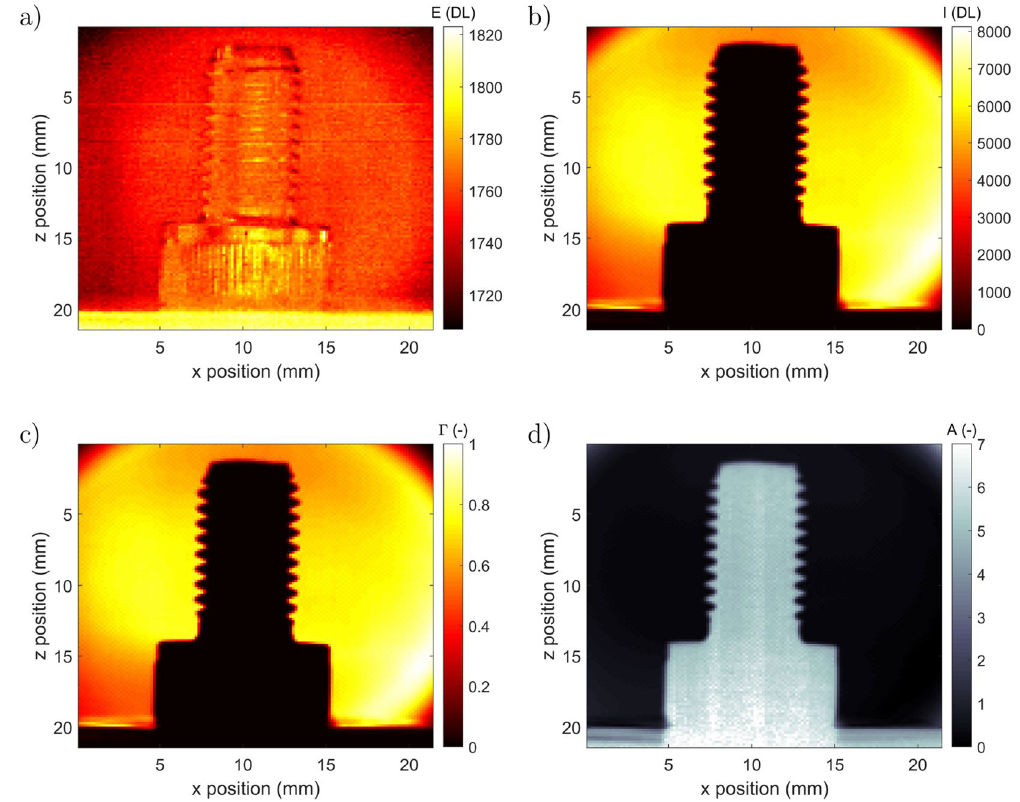
Figure 3. Measured images at integration time IT = 200 μs and θ = 46°: ( a ) proper emission E ( x , z , (cid:31) , T ) , ( b ) spectral signal I ( x , z , (cid:31) , C ) at (cid:31) = 4 μm, ( c ) calculated transmittance Ŵ( x , z , (cid:31) , C ) from Eq. 3 and ( d ) calculated absorbance A ( x , z , (cid:31) , C ) from Eq. 4. (Created with MATLAB 2020a, https ://mathw